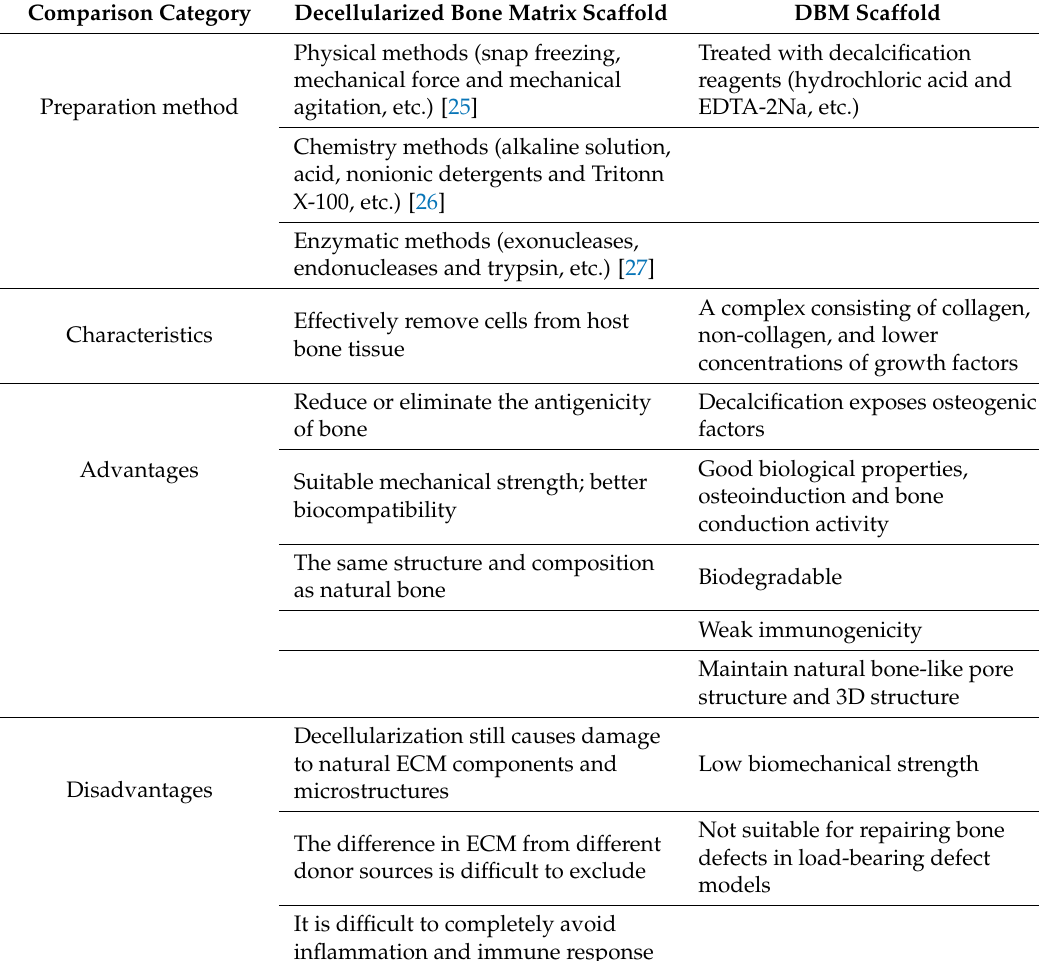
Table 1. Comparison of decellularized and DBM